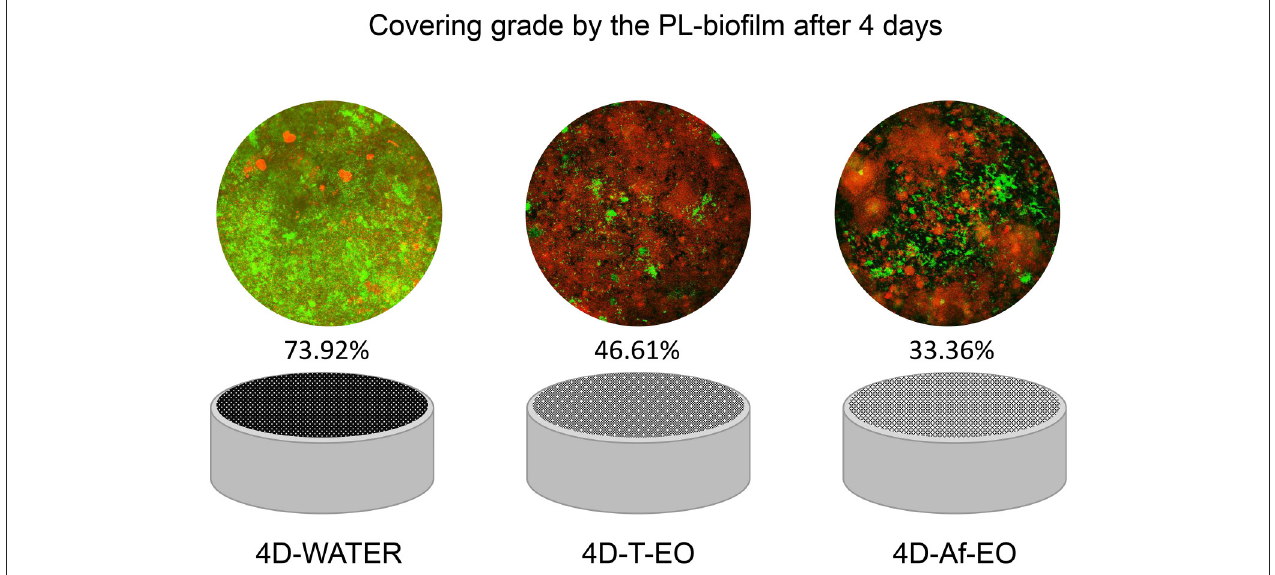
FIGURE 5 | Representative images and graphics of the disks covering grade by the PL- biofilm after 4 days of continuous use of sterile water (4D-WATER), traditional essential oils (4D-T-EO), and alcohol-free essential oils (4D-Af-EO).